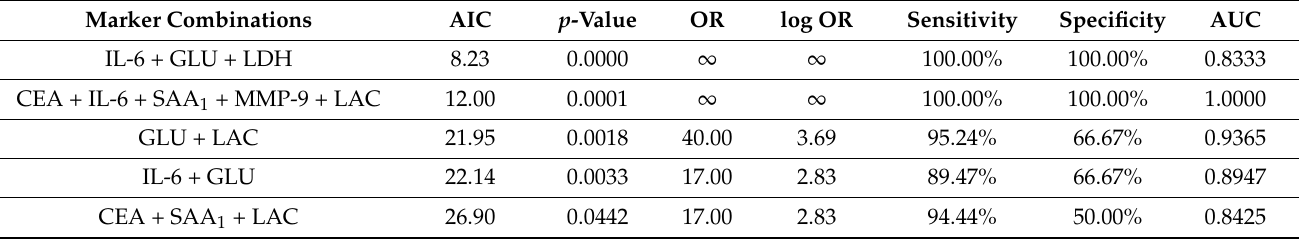
Table 11. The diagnostic efficiency of multi-biomarker models to distinguish stage IIB NSCLC patients from stage IIA NSCLC patients.